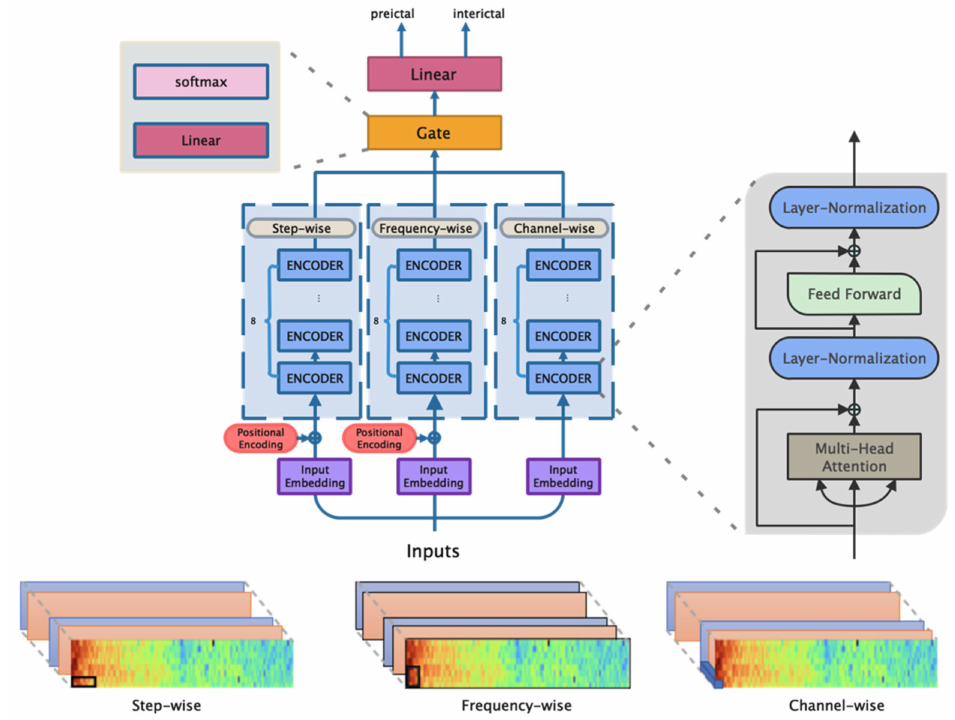
Figure 1. The model architecture of three-tower transformer